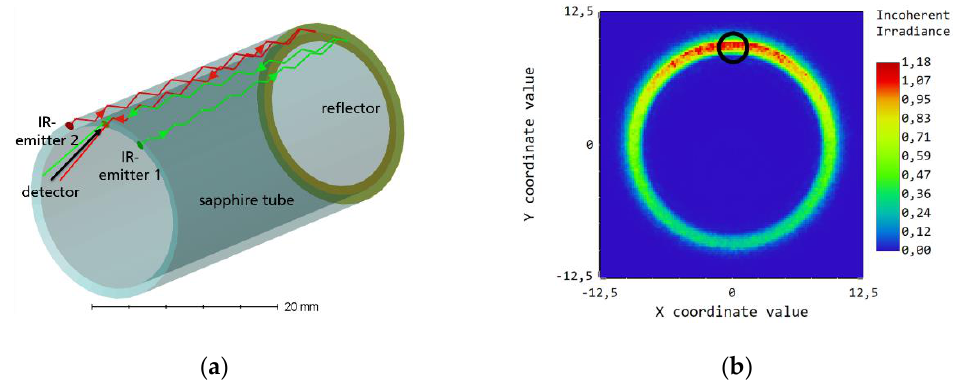
Figure 5. ( a ) Raytracing concept for a tubular ATR element with two infrared emitters placed at a wedged entrance side and a gold-coated reflector at the other side. ( b ): Simulated intensity distribution of the IR radiation, which is reflected from the mirror (direct reflections of the radiation from the first sapphire surface are not shown) on the entrance side. The black ring indicates the position of the IR detector. The false color scale on the right side describes in a. u. the irradiance on the exit area of the sapphire tube. The total exiting intensity is ≈ 26% of the entering intensity of the two emitters.